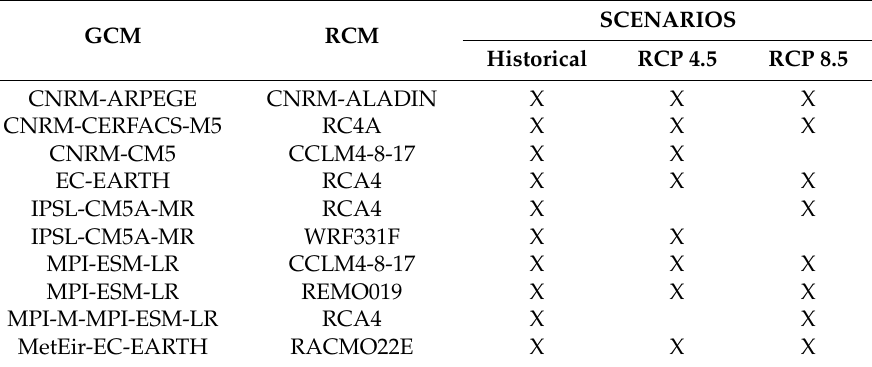
Table 3. Climatic models available for the study. GCM RCM